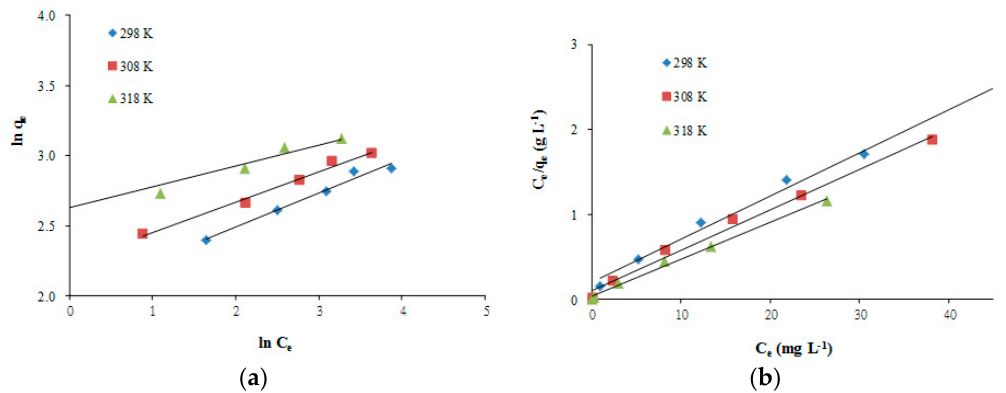
Figure 6. Linearized parameters of the adsorption isotherm models for Sr on the composite magnetic nanoparticles. ( a ) Freundlich isotherm model; ( b ) Langmuir isotherm model.